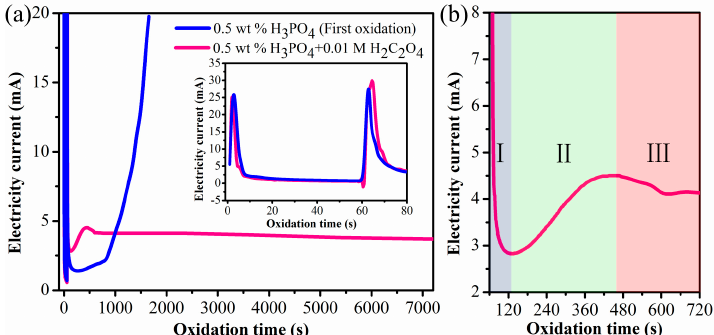
Figure 2. ( a ) Current–time variation during anodization in an electrolyte consisting of 0.5 wt % H 3 PO 4 and 0. 5 wt % H 3 PO 4 with the addition of 0.01 M H 2 C 2 O 4. , the illustration of (a) is